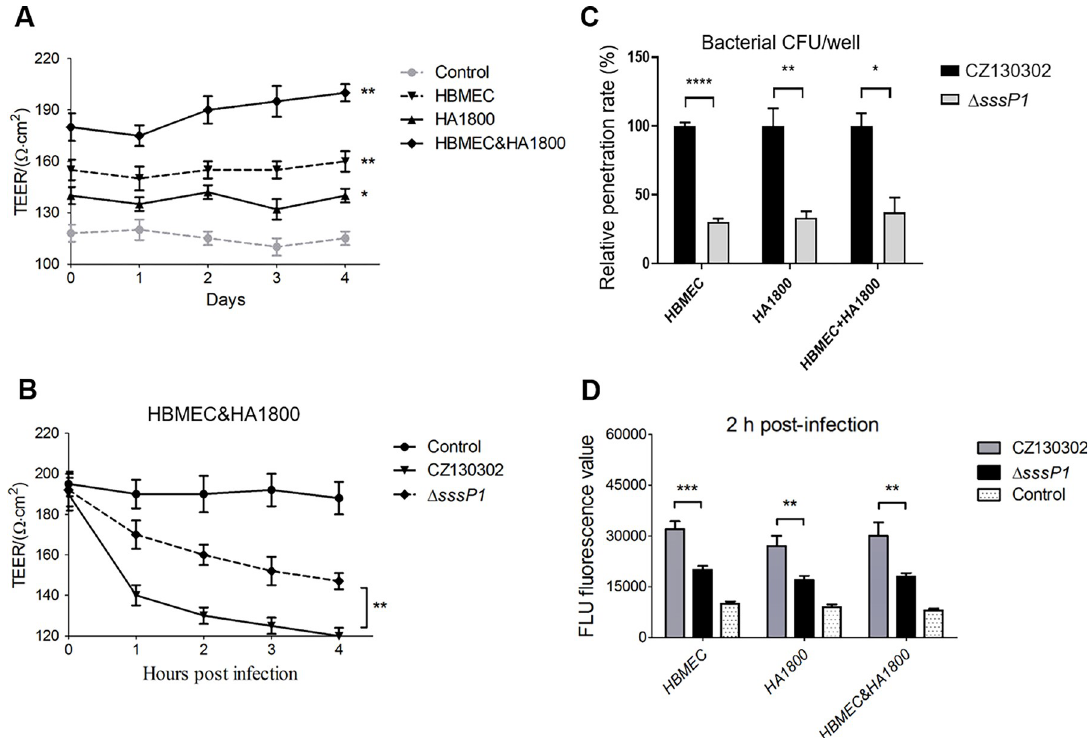
Fig 3. SssP1 promotes S . suis to cross the BBB in vitro . All data are represented as mean ± SEM of triplicate samples ( ���� P < 0.0001, �� P < 0.01, � P < 0.05). (A) The curves showed the TEER values of three types of models within 4 days. The HBMECs and astrocyte cell HA1800 were respectively or jointly inoculated into a transwell chamber to establish three types of BBB models in vitro (S1 Fig). (B) The curves showed the TEER values of the HBMEC&HA18000 joint BBB model infected with the indicated S . suis strains. (C) The penetration rates of three types of models infected with the indicated strains were measured, and the data showed the calculated value of the bacterial CFU in the bottom chamber/ upper + bottom chambers. (D) The fluorescence values of the bottom chambers at OD428 were measured to show the permeability of Fluorescein (FLU) in three type of BBB models infected with the indicated bacterial strains. The boiled CZ130302 was used as control.